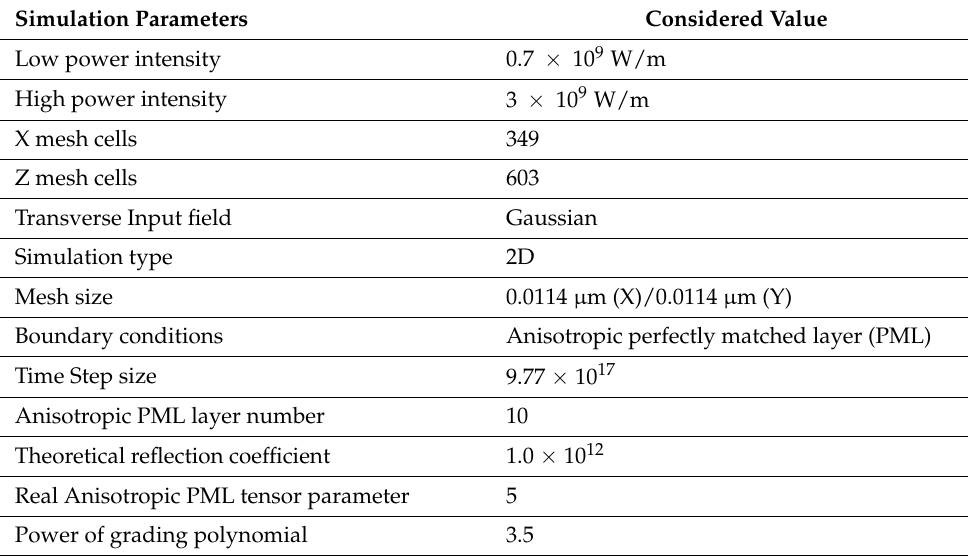
Table 2. Simulation parameters of proposed 2 × 1 multiplexer.